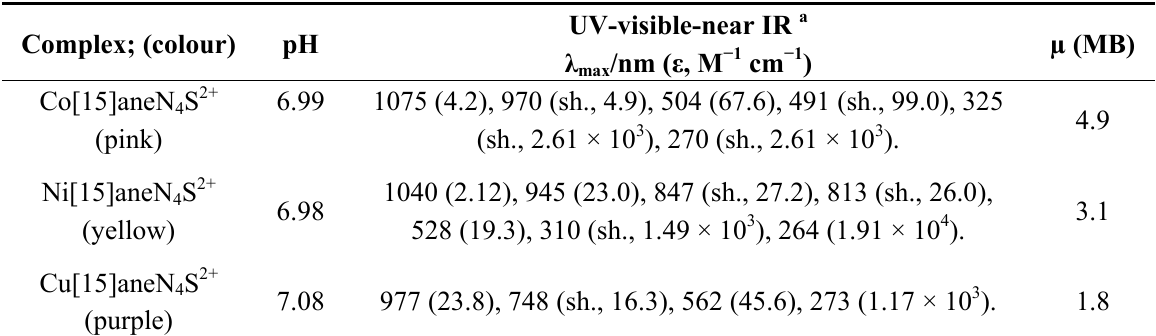
Table 4. Spectroscopic UV-visible-near IR data and magnetic moments (µ) for the Co(II), Ni(II) and Cu(II) complexes of [15]aneN 4